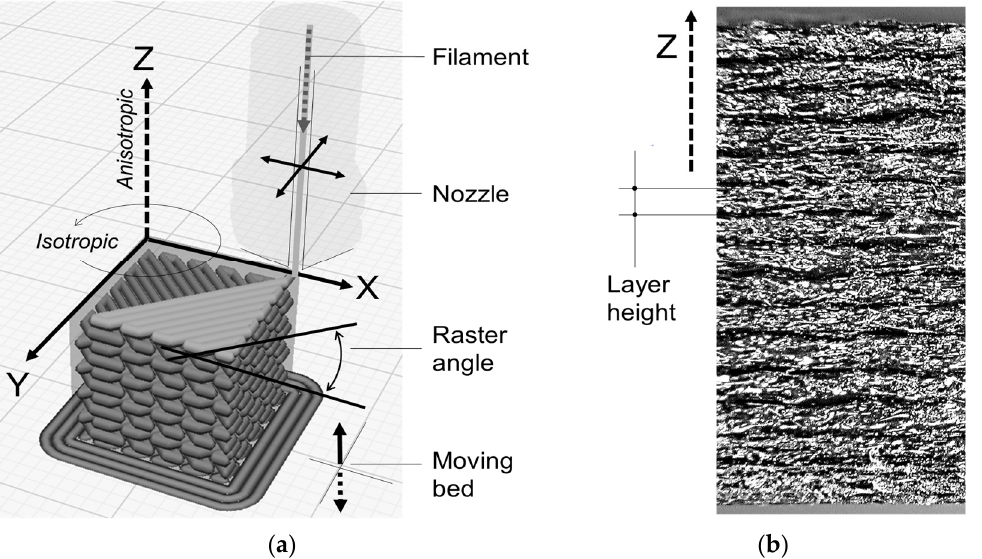
Figure 1. Scheme of the FDM process. ( a ) Details of the external surface of a printed component made with a carbon fiber-reinforced polyamide filament. ( b )